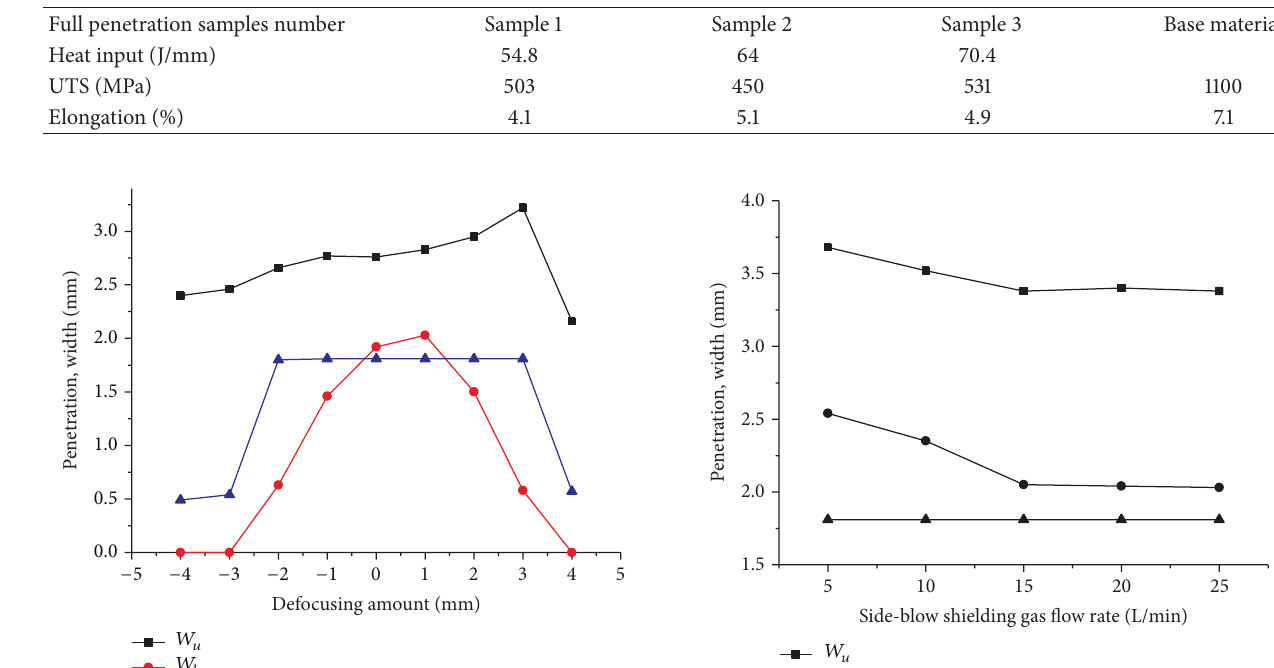
Table 1: UTS and elongation of the welded joints.